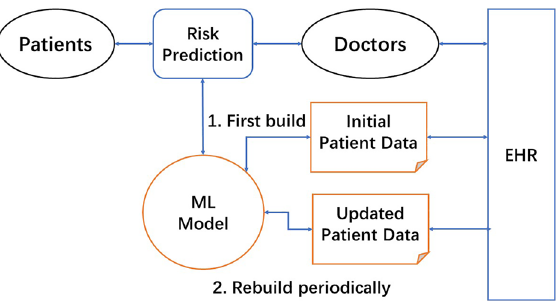
Figure 1. High-level diagram of data-centric and machine learning (ML) enabled learning health system (LHS) design for risk prediction. The ML model is first built with initial patient data from EHRs. LHS